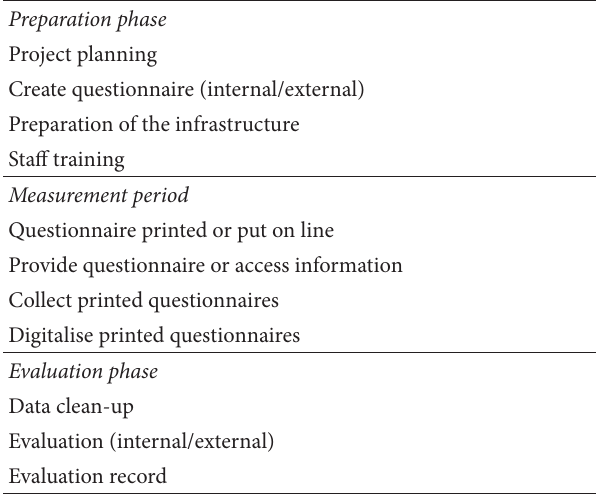
Table 1: Summary of the questionnaire used. Table2:Overviewofthedifferentphasesofanassessmentofpatient